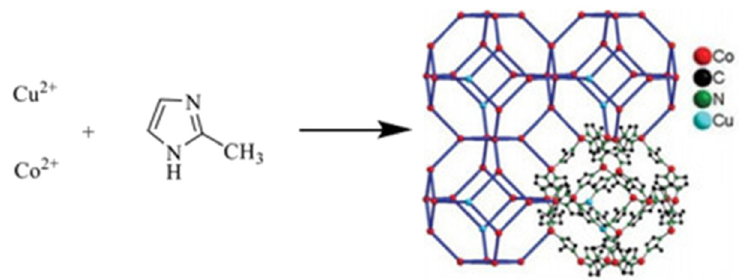
Figure 2: Components and SOD - type framework structure of CuCo -